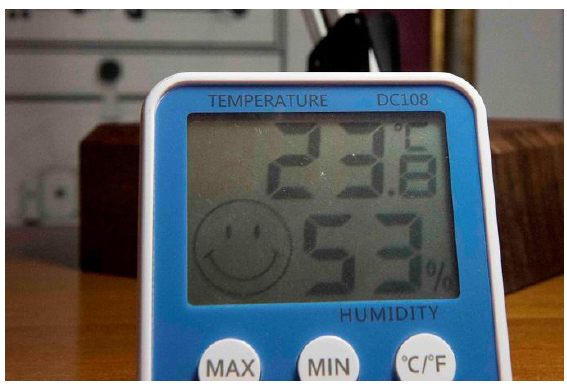
Figure 3. Image with a value of 16 for the diaphragm opening